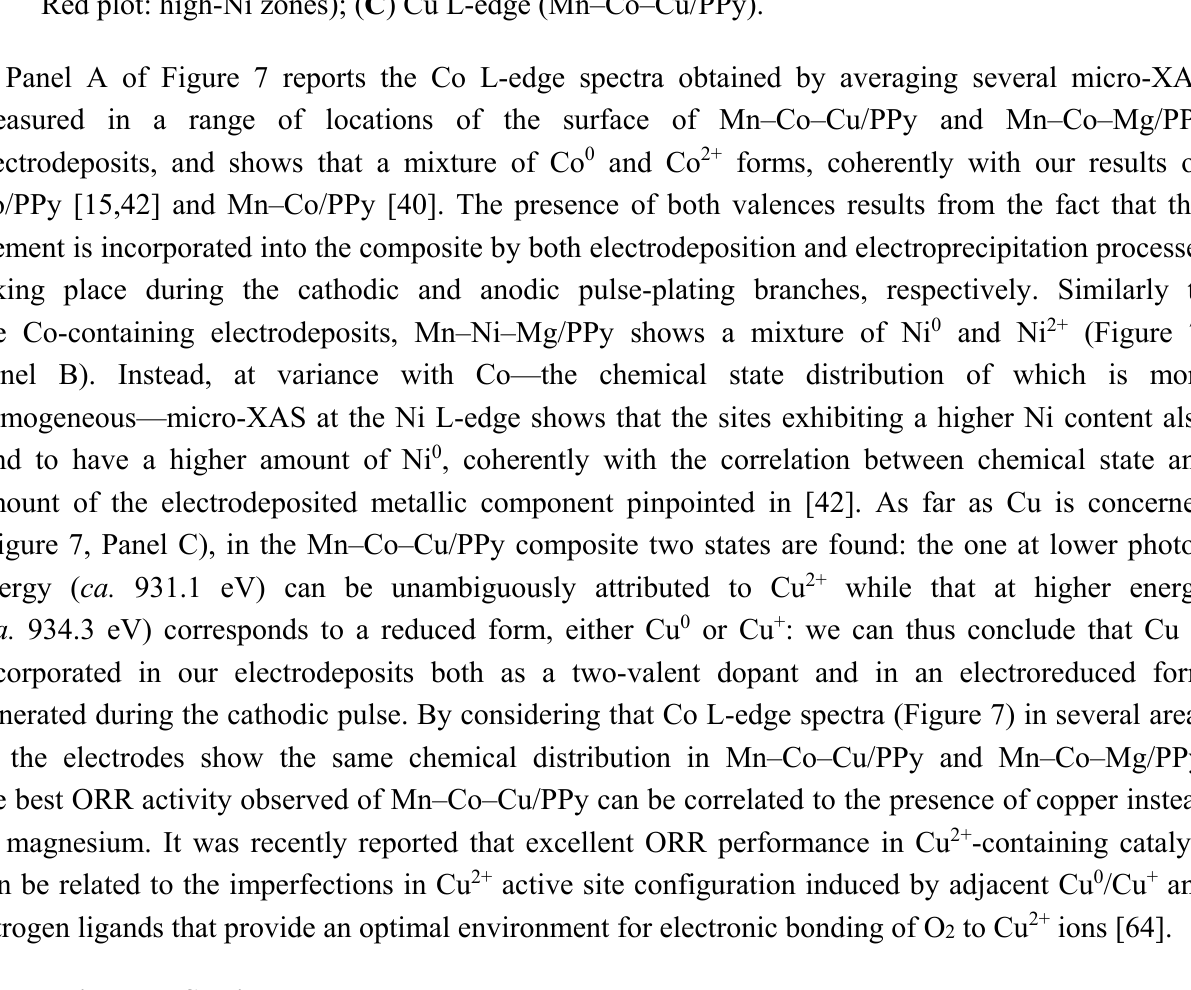
Figure 7. Micro-XAS of electrodeposited Mn-based/PPy composites: ( A ) Co L-edge (black plot: Mn–Co–Cu/PPy, red plot: Mn–Co–Mg/PPy); ( B ) Ni L-edge (Mn–Ni–Mg/PPy. Red plot: high-Ni zones); ( C ) Cu L-edge